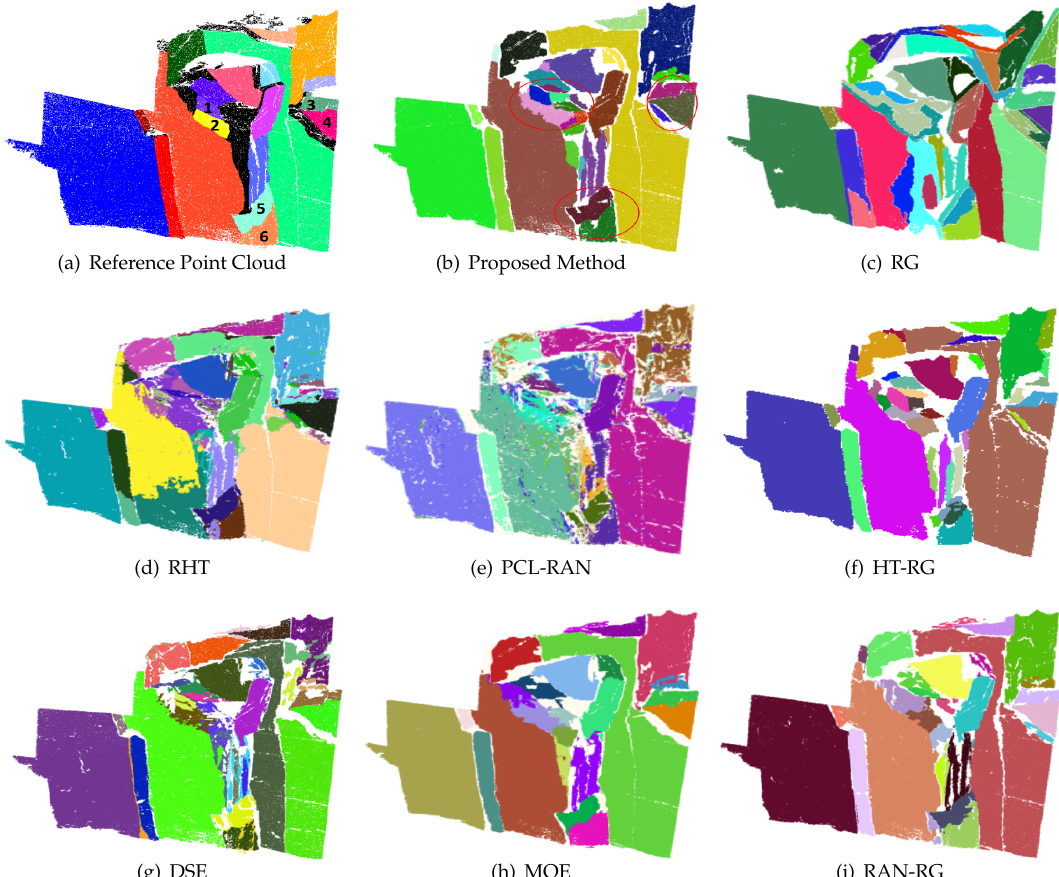
Figure 9. Detection result of